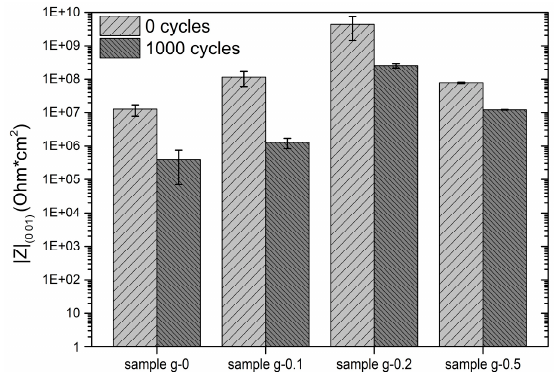
Figure 13. Bode impedance modulus |Z|(0.01 Hz) before and after the scrub test.